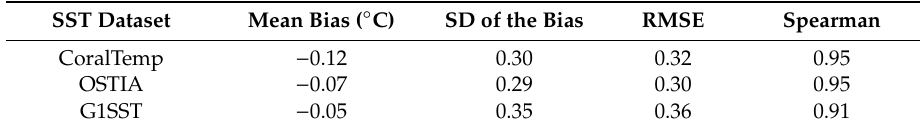
Table 8. Mean bias (satellite—in situ), standard deviation of the bias, root mean square error (RMSE) of the bias, and Spearman correlations between satellite-based SST datasets and averaged in situ temperature for Margarita Reef from 1 March 2019–24 December 2019 (~10 months) for CoralTemp, and OSTIA datasets. The G1SST dataset is only from 1 March 2019–8 December 2019.